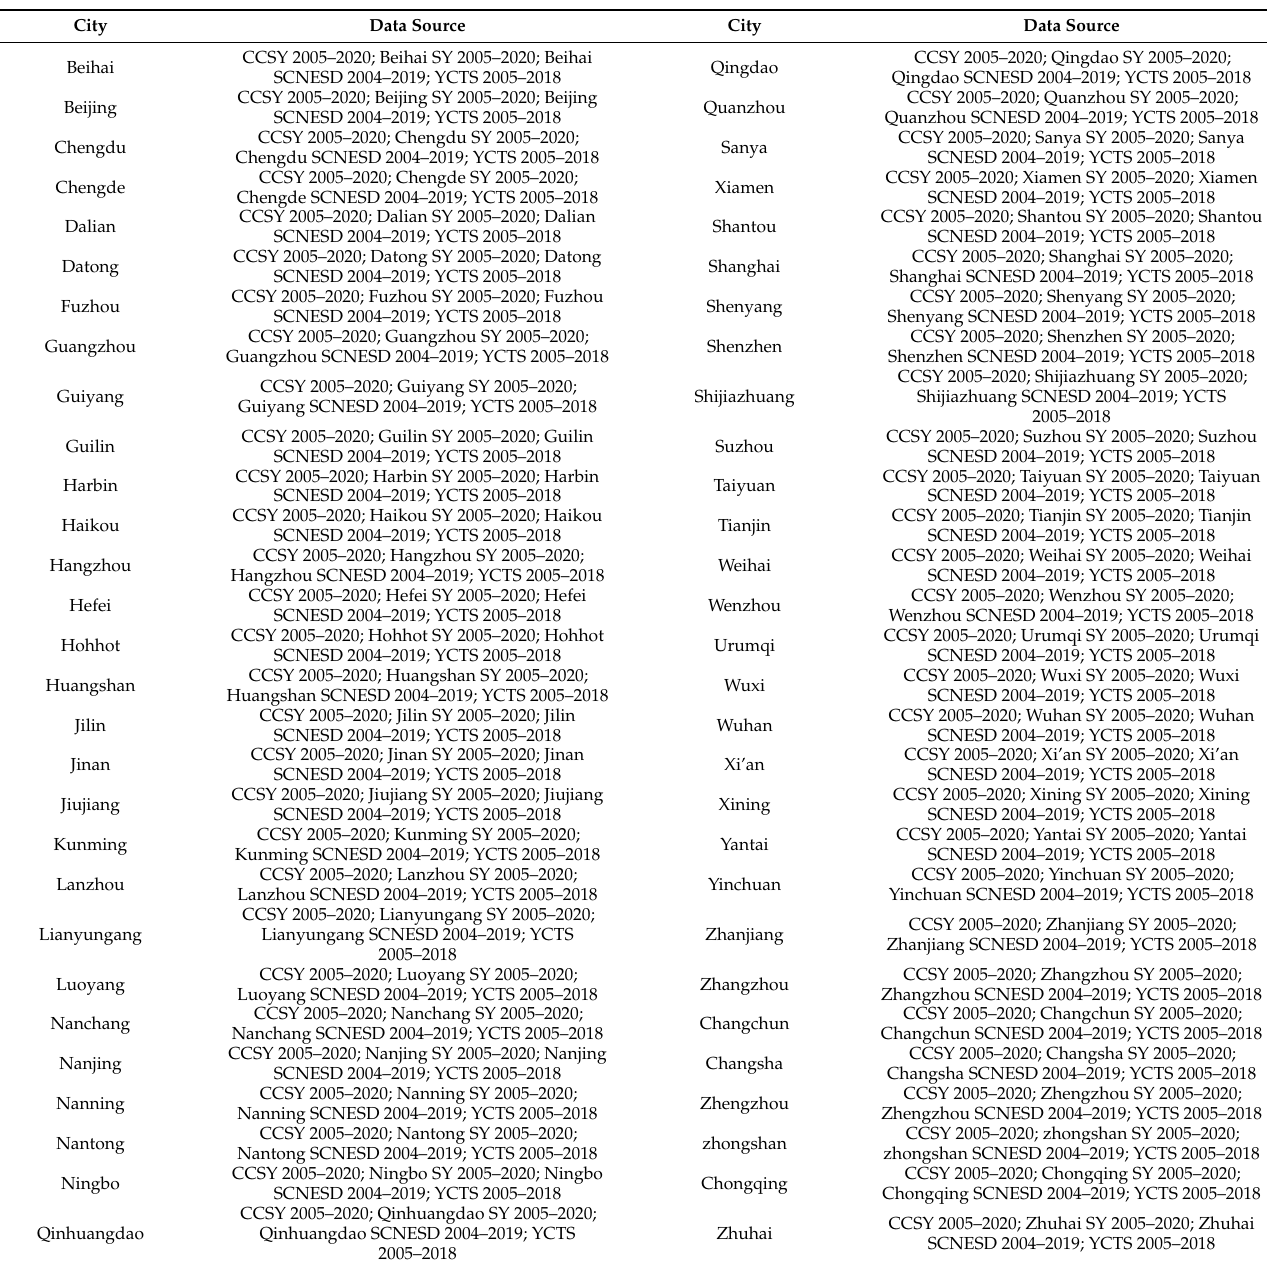
Table A1. Data sources for each case